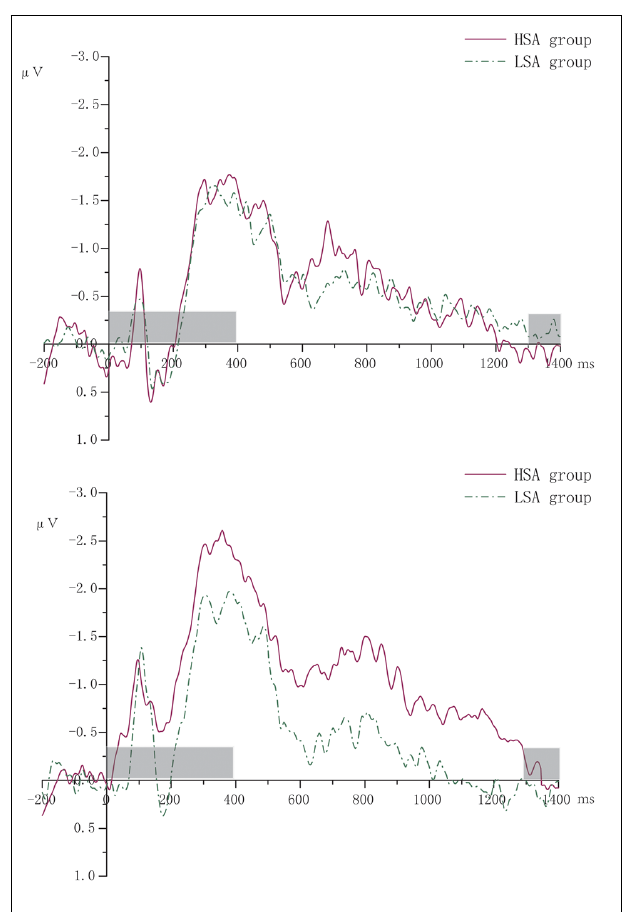
FIGURE 2 | The grand averaged waveforms of contralateral delay activity (CDA) of high (HSA) and low socially anxious (LSA) groups. The left was for two memory items. The right was for four memory items. The gray-shaded area was the rendering phase of memory array or test array.